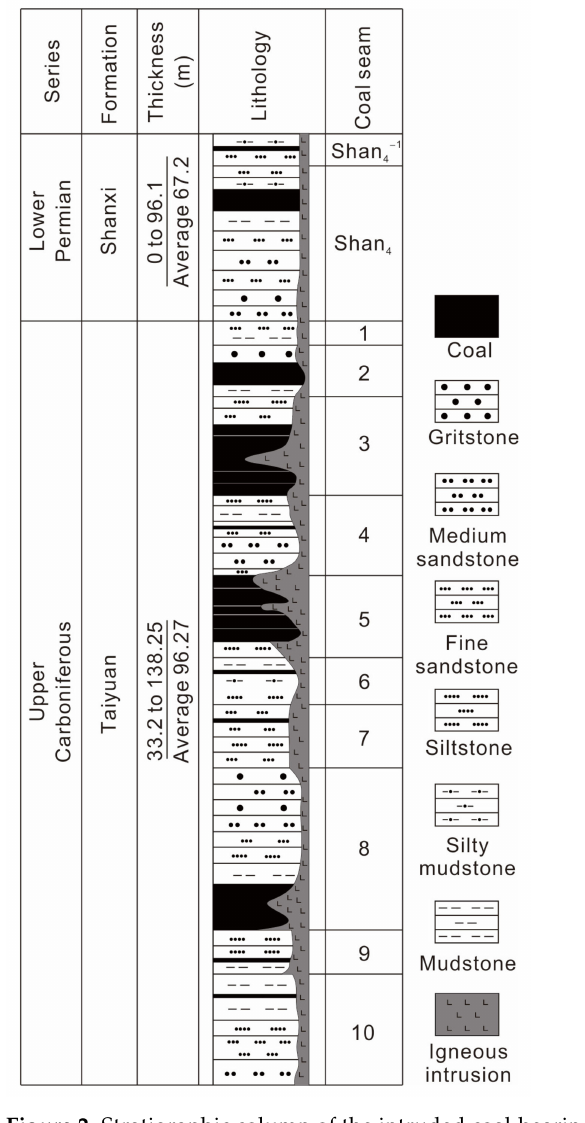
Figure 2. Stratigraphic column of the intruded coal-bearing strata in the Tashan Coal